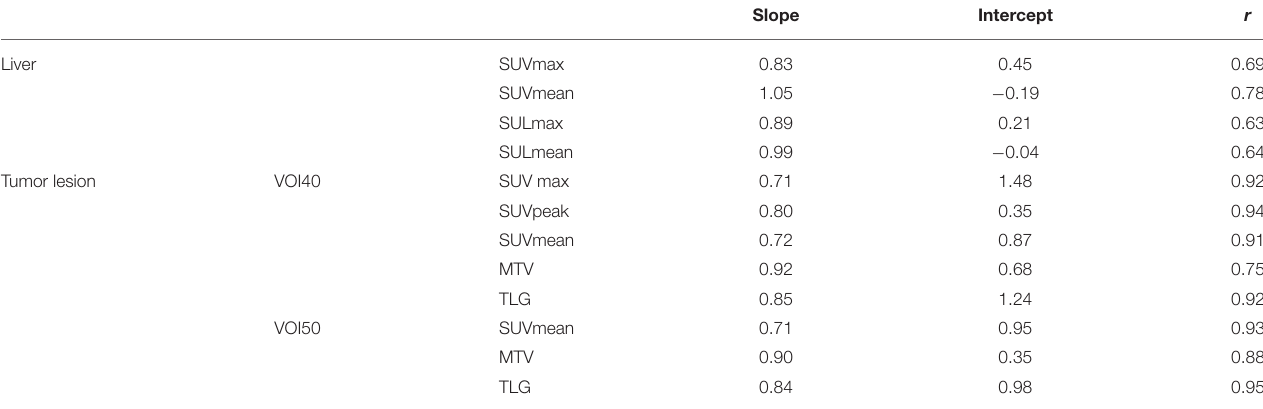
TABLE 3 | The result of linear regression analysis where x-axis is PET/MR measurements and y-axis is PET/CT